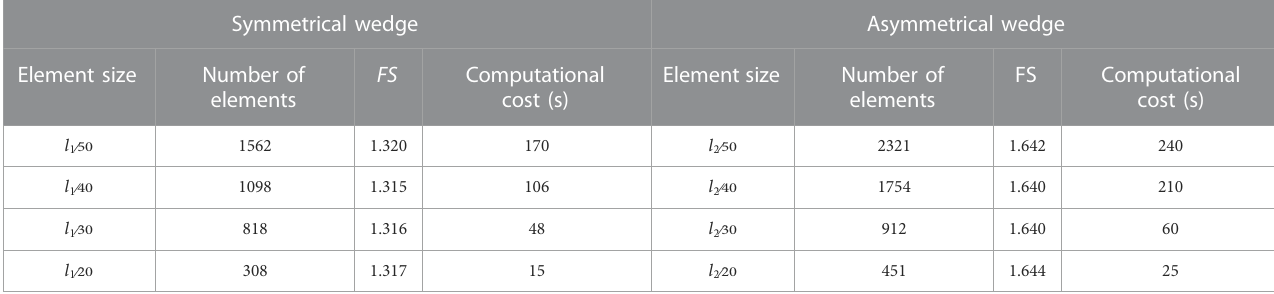
TABLE 6 Effects of element size of interface contact elements on the FS